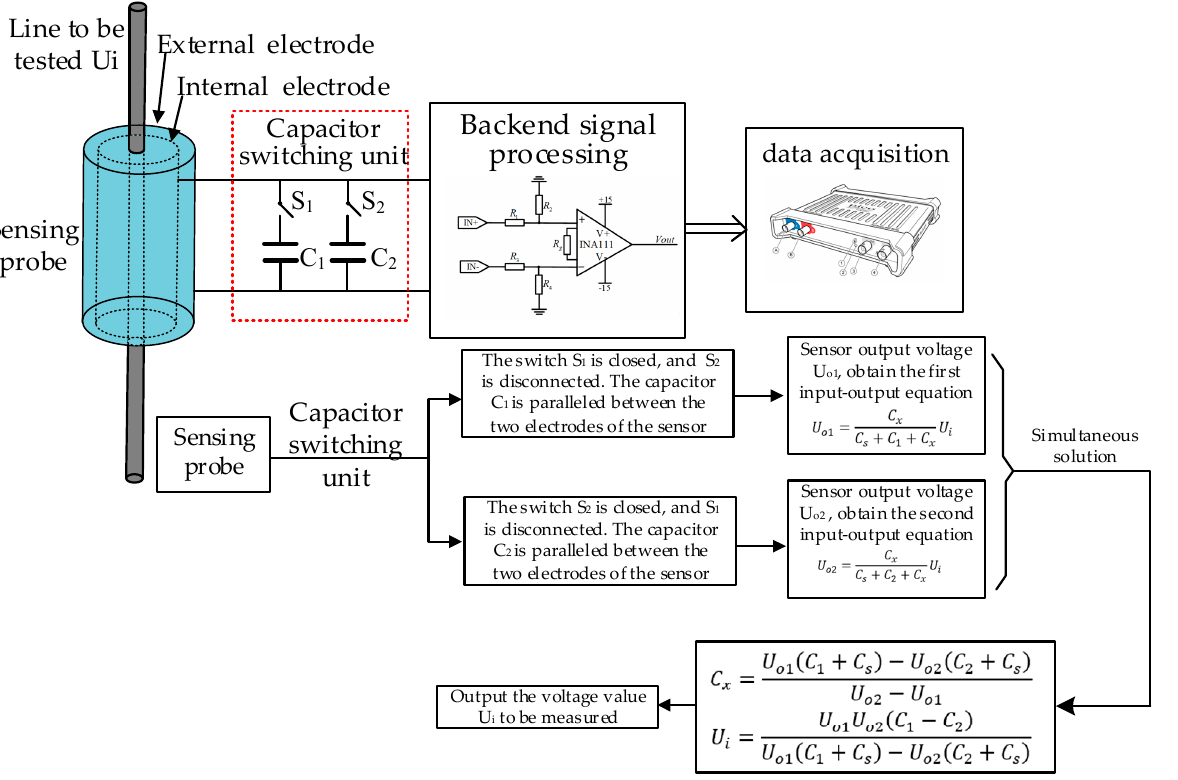
Figure 9. Measurement system and speci fi c implementation steps.